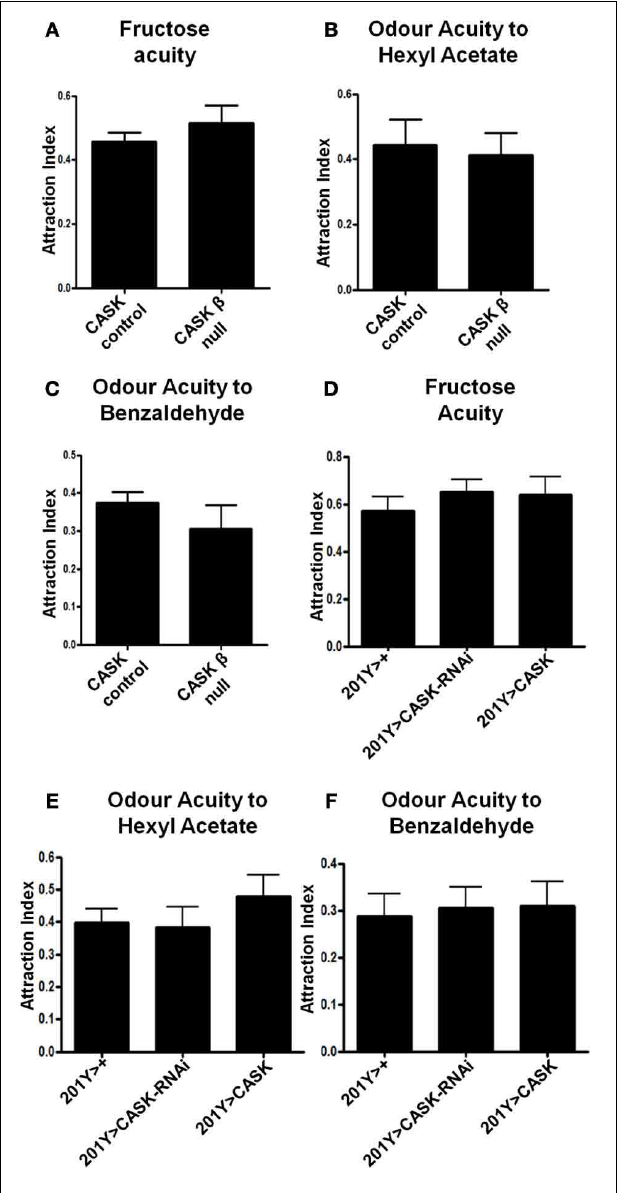
FIGURE 7 | CASK does not regulate odor or fructose acuity. (A–C) CASK β deletion did not affect odor or fructose acuity compared to controls ( p > 0 . 05, n = 3, unpaired t -test). (D–F) CASK knockdown or overexpression in the γ –lobe neurons of the mushroom body had no significant effects on odor or fructose acuity compared to controls ( p > 0 . 05, n = 3, One Way ANOVA with a Bonferroni post-hoc test).